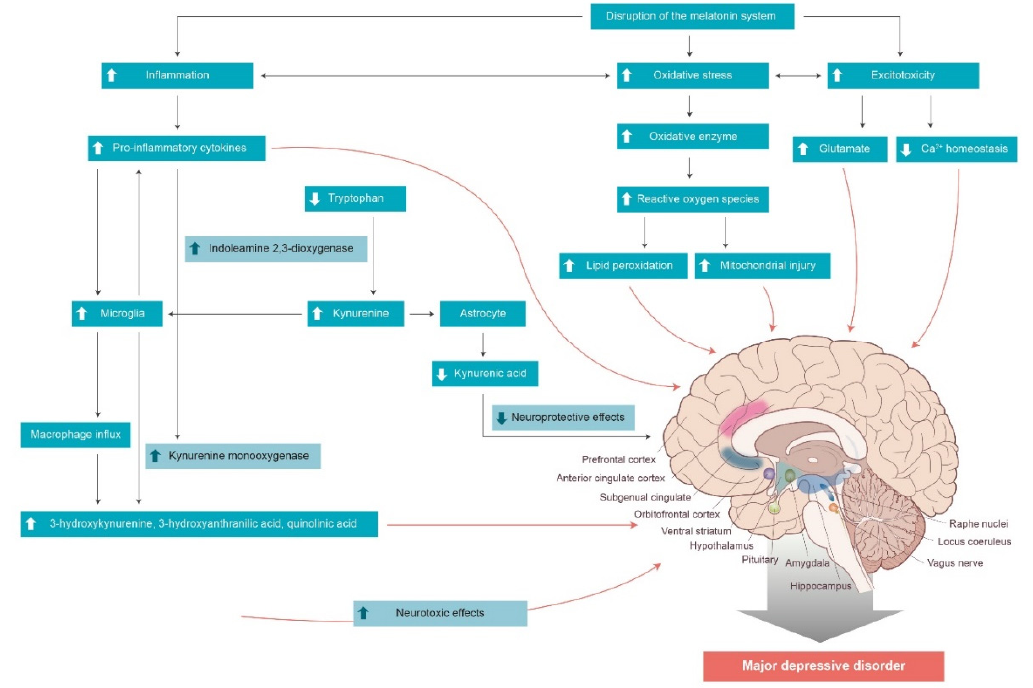
Figure 1. Disruption of the melatonin system can exacerbate inflammatory conditions, which in- crease neurotoxic metabolites through the kynurenine pathway or directly exert neurotoxic effects on specific brain regions. Disruption of the melatonin system can also lead to oxidative stress and excitotoxicity, further contributing to neuroinflammation, as well as exerting direct neurotoxic ef- fects. Neuroinflammation and subsequent alterations in brain regions involved in emotional regu- lation have been suggested as an underlying mechanism for the pathophysiology of major depres- sive disorder.